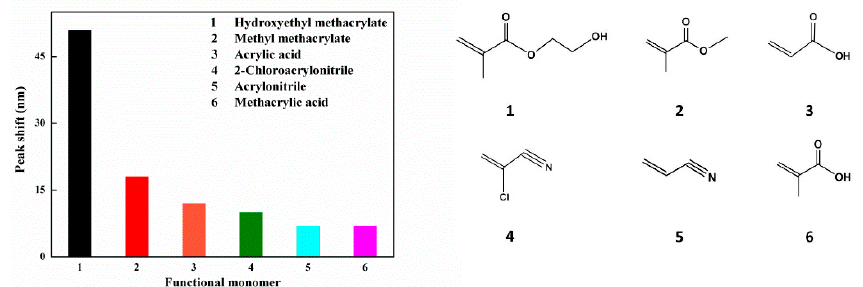
Figure 1. Peak shifts of the inverse opal polymeric photonic crystals (IOPPCs) with di ff erent functional monomers (30 mM p-nitrophenol (PNP)): ( 1 ) hydroxyethyl methacrylate; ( 2 ) methyl methacrylate; ( 3 ) acrylic acid; ( 4 ) 2-chloroacrylonitrile; ( 5 ) acrylonitrile; ( 6 ) methacrylic acid.